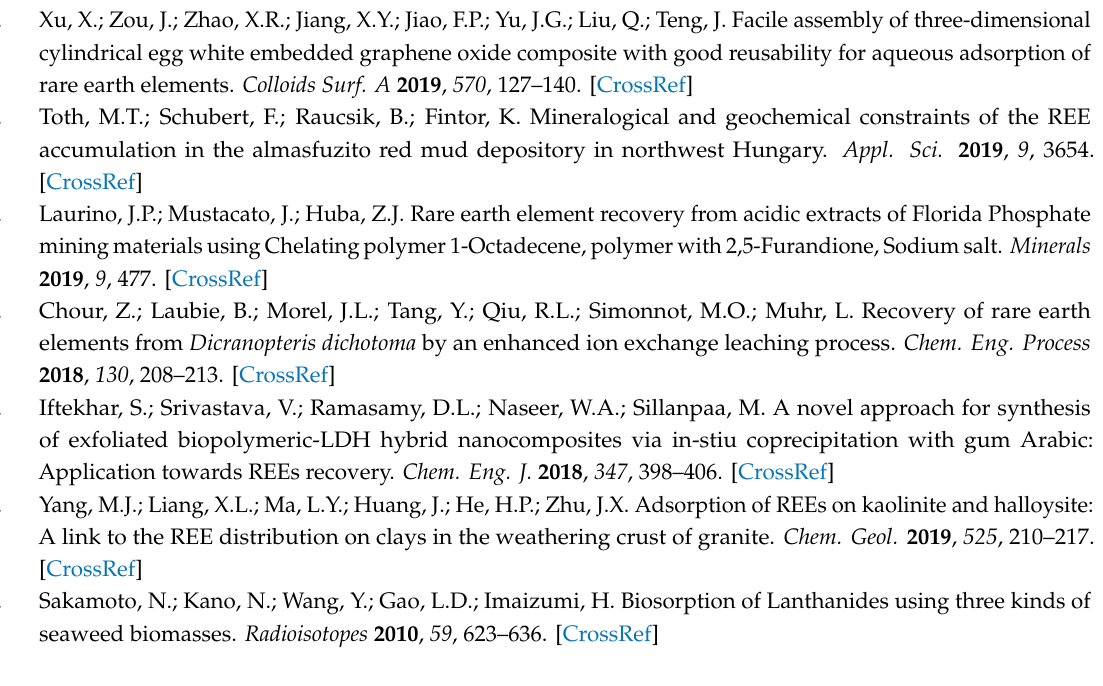
Figure S1: E ff ect of common ions (Ca 2 + , Mg 2 + , Na + and K + ) on the removal e ffi ciency of lanthanides using ground original sample, Figure S2: Adsorption capacity of (a) La(III) and (b) Eu(III) both in single and multiple solution by using L1 or L2, Figure S3: Langmuir isotherm for La(III) adsorption onto L2, Figure S4: Freundlich isotherm for La(III) adsorption onto L2, Figure S5: Langmuir isotherm fitting for Eu(II) adsorption onto L2, Figure S6: Freundlich isotherm fitting for Eu(III) adsorption onto L2, Figure S7: The kinetic models for La(III) adsorption onto L2, Figure S8: The kinetic models for Eu(III) adsorption onto L2, Figure S9: Plots of lnK d vs. 1 / T for the estimation of thermodynamic parameters obtained for the adsorption of (a) La(III) and (b) Eu(III) on L2, Figure S10: Plots of q e vs. ln ( q e / c e ) for (a) La(III) and (b) Eu(III) on L2, Figure S11: Optimized structures of (a) [Eu(H 2 O) 8 ] 3 + and (b) [Eu(EDTA)(H 2 O)] − . Table S1: Coe ffi cients of Langmuir and Freundlich isotherms for La(III) adsorption onto L2, Table S2: Coe ffi cients of Langmuir and Freundlich isotherms for Eu(III) adsorption onto L2, Table S3: Kinetic parameters of Pseudo-first order and Pseudo-second order, Table S4: Kinetic parameters of Elovich model and Intraparticle di ff usion, Table S5: Thermodynamic parameters for the adsorption of La(III) on L2, Table S6: Thermodynamic parameters for the adsorption of Eu(III) on L2, Table S7: Bond lengths of [Eu(H 2 O) 8 ] 3 + shown in Panel (a) of Figure S3, Table S8: Bond lengths of [Eu(EDTA)(H 2 O)] − in Panel (b) of Figure S11, Table S9: Bond lengths of [Eu(H 2 O) 8 ] 3 + shown in Panel (a) of Figure S11, Table S10: Bond lengths of [Eu(EDTA)(H 2 O)] − in Panel (b) of Figure